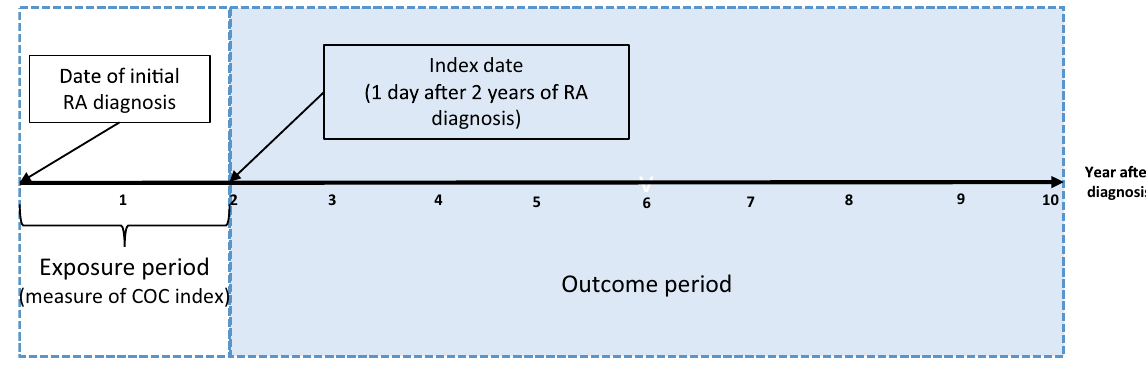
Figure 1. The schematic diagram of the time frame for